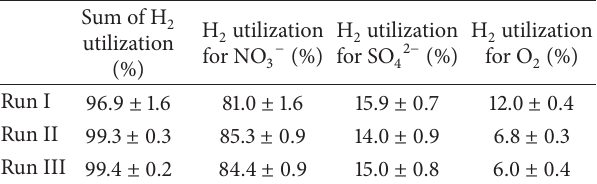
Figure 5: Average rate of hydrogen utilization by the biofilm, aver- age hydrogen concentration in the effluent, and average hydrogen flux at different experimental periods. utilization in the Table 4: The H 2